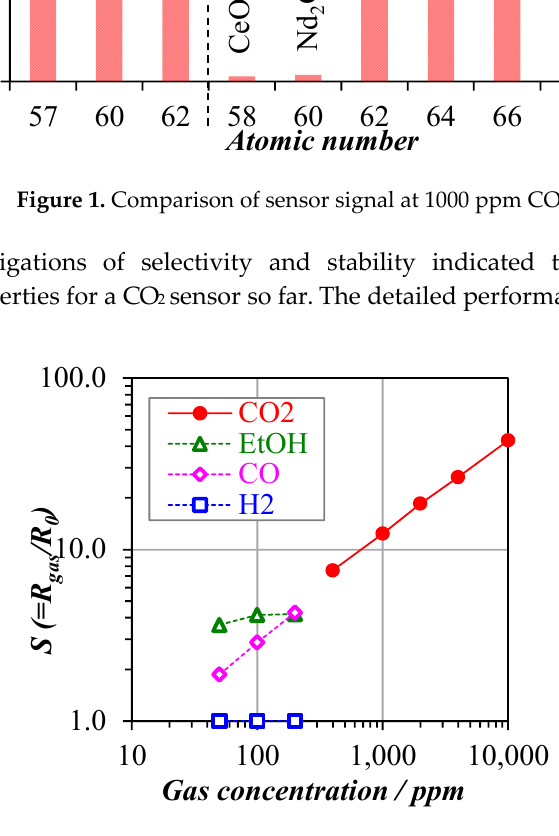
Figure 2. Sensing performance of hexagonal La 2 O 2 CO 3